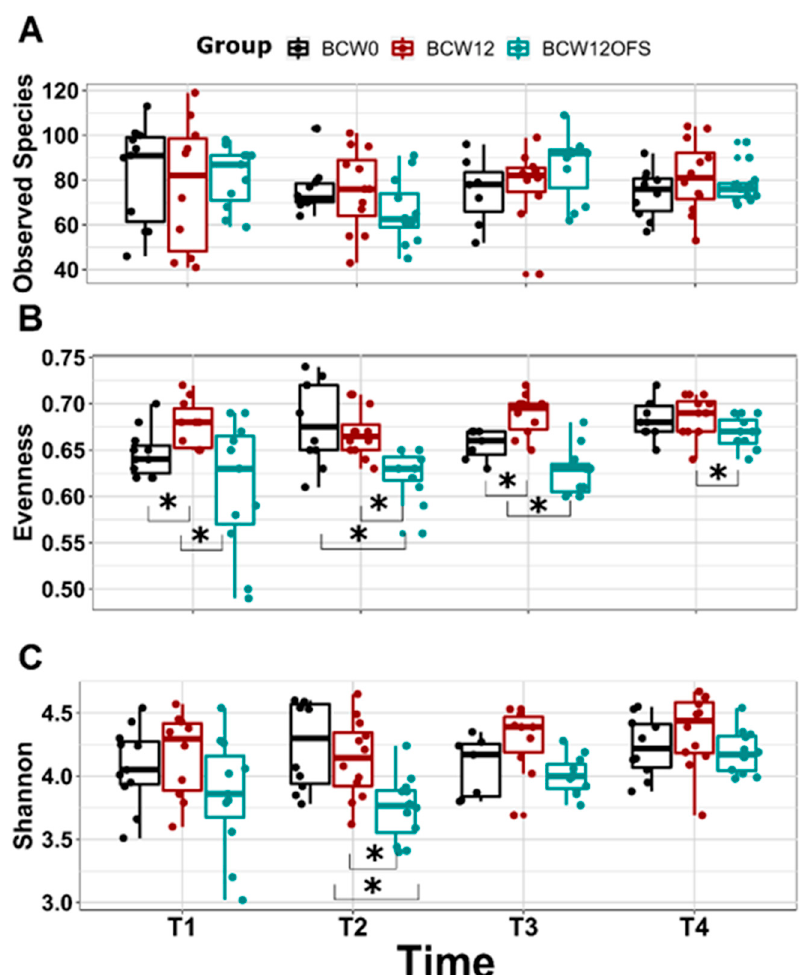
Figure 8. Mouse gut microbial alpha diversity across time points. Alpha diversity metrics measured at T1 (day 5—post-FMT), T2 (day 13—post tumor cell injection), T3 (day 22—post paclitaxel), and T4 (day 27/28—euthanasia) and compared between groups using Kruskal-Wallis pairwise tests ( A – C ). Observed Species did not differ significantly between groups ( A ). Evenness differed significantly between groups at each timepoint ( B ). Shannon diversity differed significantly between groups at T2 (day 13) ( C ). * Indicates a significant difference ( p < 0.05). Data are presented as ± SEM and each dot represents an individual mouse’s results. BCW0 ( n = 10), BCW12 ( n = 12), BCW12OFS ( n = 12).